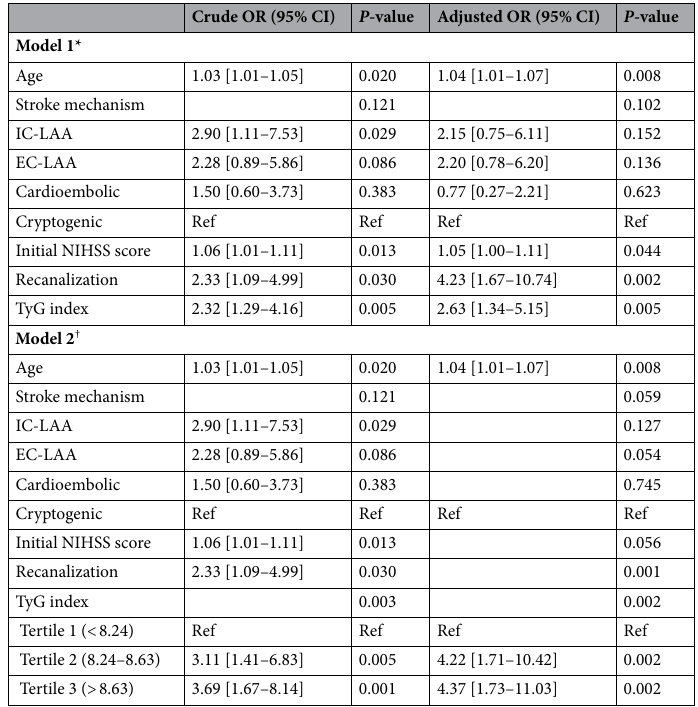
Table 2. Multivariable logistic regression analysis of possible predictors for early recurrent ischemic lesion. IC-LAA intracranial large artery atherosclerosis, EC-LAA extracranial large artery atherosclerosis, NIHSS